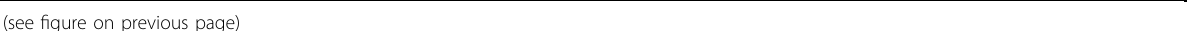
Fig. 1 Intestinal epithelial cell (IEC)-speci fi c deletion of Cdk5rap3 leads to ablation of Paneth cells. a Scheme of mouse breeding to generate IEC-speci fi c KO mice. b Quantitative RT-PCR analysis of Cdk5rap3 mRNA using the primers speci fi c for fl oxed exons ( n = 3 mice per genotype); Total RNA was isolated from intestinal crypts. c Immunoblotting of Cdk5rap3 in the lysate of intestinal epithelial cell lysates. d Immunohistochemistry of Cdk5rap3 in wild-type and Cdk5rap3 KO ileal sections. e Signi fi cant loss of Paneth cells in Cdkrap3 Δ / Δ IEC intestine. The number of Paneth and goblet cells were counted in double-blinded fashion from more than 20 crypts, and 4 mice of each phenotypes were scored. **** p < 0.0001 ( n = 4 mice per genotype). f Lysozyme staining of ileal sections of wild-type and Cdkrap3 Δ / Δ IEC mice. Lysozyme-positive cells per crypt were scored. *** p < 0.001 ( n = 4 mice per genotype). g Electron micrographs of the crypts of wild-type and Cdk5rap3 Δ / Δ IEC mice. Mitotic cells with condensed chromatin were marked by solid arrows. h Quantitative RT-PCR analysis of cell type-speci fi c gene expression. Total RNA was isolated from scraped cells of ileal section. * p < 0.05, * * p < 0.01, *** p < 0.001 ( n = 4 mice per genotype). i The number of enteroendocrine cells (Chromogranin A-positive) in wild-type and Cdkrap3 Δ / Δ IEC intestine. The number of ChA + cells per crypt-villus axis was counted and four mice of each phenotypes were scored. j Mitotic cells (phospho-Histone H3 Ser10 staining) in wild-type and Cdk5rap3 Δ / Δ IEC ileal sections. The number of p-H3 + cells per crypt-villus axis was scored. * * p < 0.01. ( n = 4 mice per